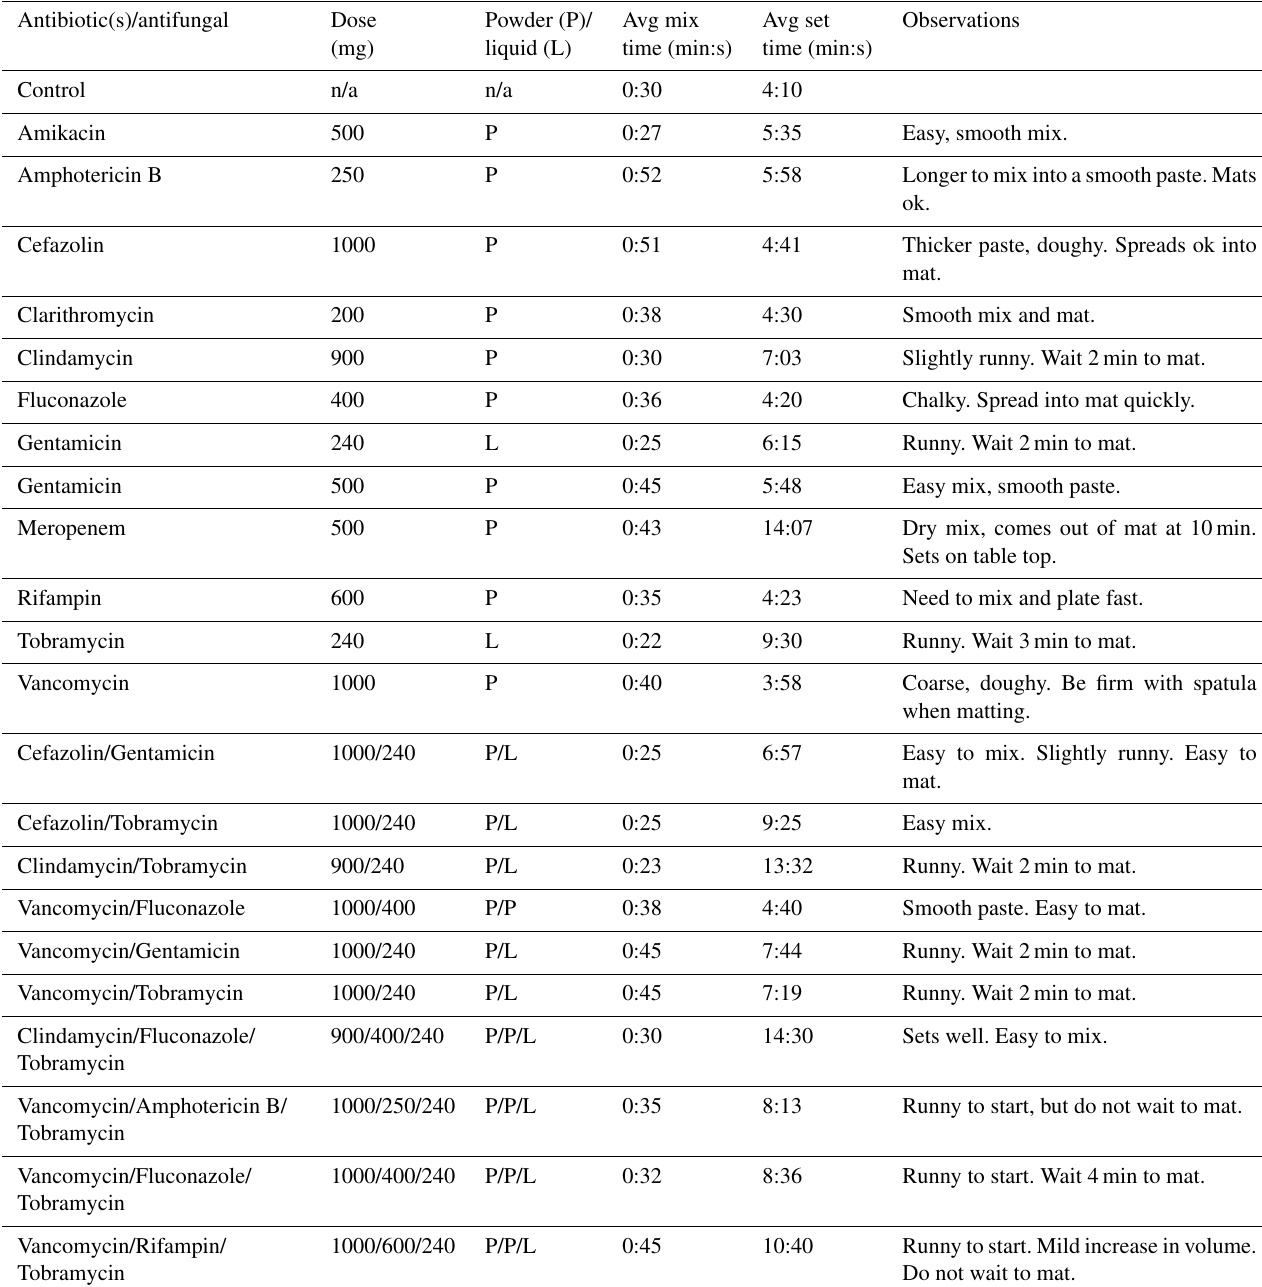
Table 1. Set times of Synthecure with various antimicrobials and combinations. Antibiotic(s)/antifungal